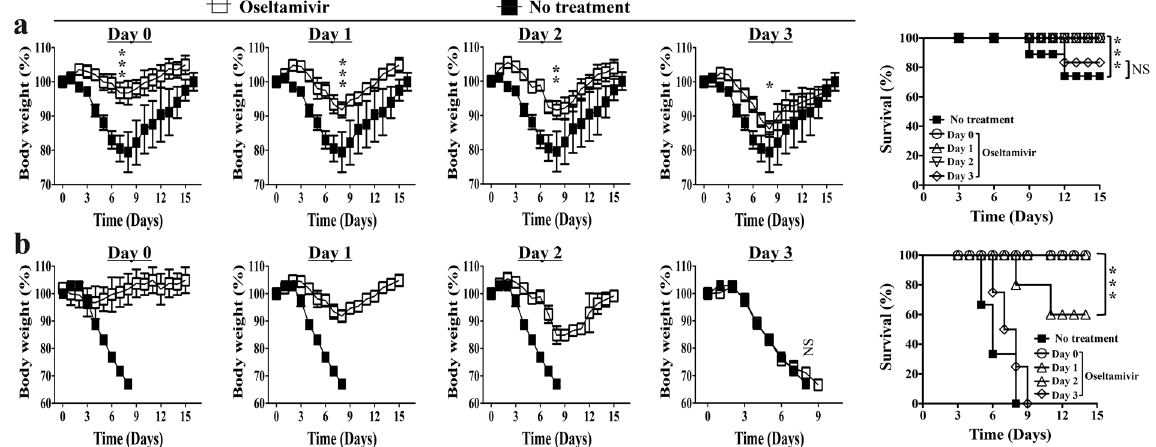
Figure 2. Protective effect of Oseltamivir disappears with delayed treatment onset. Early treatment of Oseltamivir effectively prevented disease of sub-lethal ( a , inoculum dose = 2.5 × 10 3 PFU) and lethal ( b , inoculum dose = 1.25 × 10 4 PFU) PR8 influenza virus infection in BALB/c mice. The protection decreases with delay of treatment and there was almost no protection with treatment from day 3- post infection. Naïve mice of comparable age were infected with stated inoculum size of PR8 virus. Control untreated mice received daily oral feeding of equal volume phosphate buffered saline (PBS) starting from the stated days post infection of the influenza virus. Data are representative of at least three similar experiments and presented as mean ± s.d. ( *** p < 0.0001; ** p < 0.001; * p < 0.01; NS = non-significant, p > 0.05; n = 6/group).